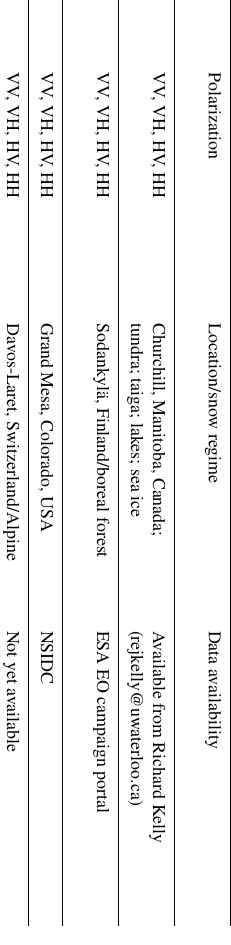
Figure 10. Demonstration of observed Ku-band VV-pol backscat- tering from two consecutive SnowSAR flight campaigns in So- dankylä, Finland. The difference in backscatter is depicted on the right, with red implying an increase. Increases in measured backscattering are correlated with the increase in SWE. The mea- sured SWE between the flights increased on average by 41mm in non-vegetated areas, which show the highest increase (figure adapted from Lemmetyinen et al.,